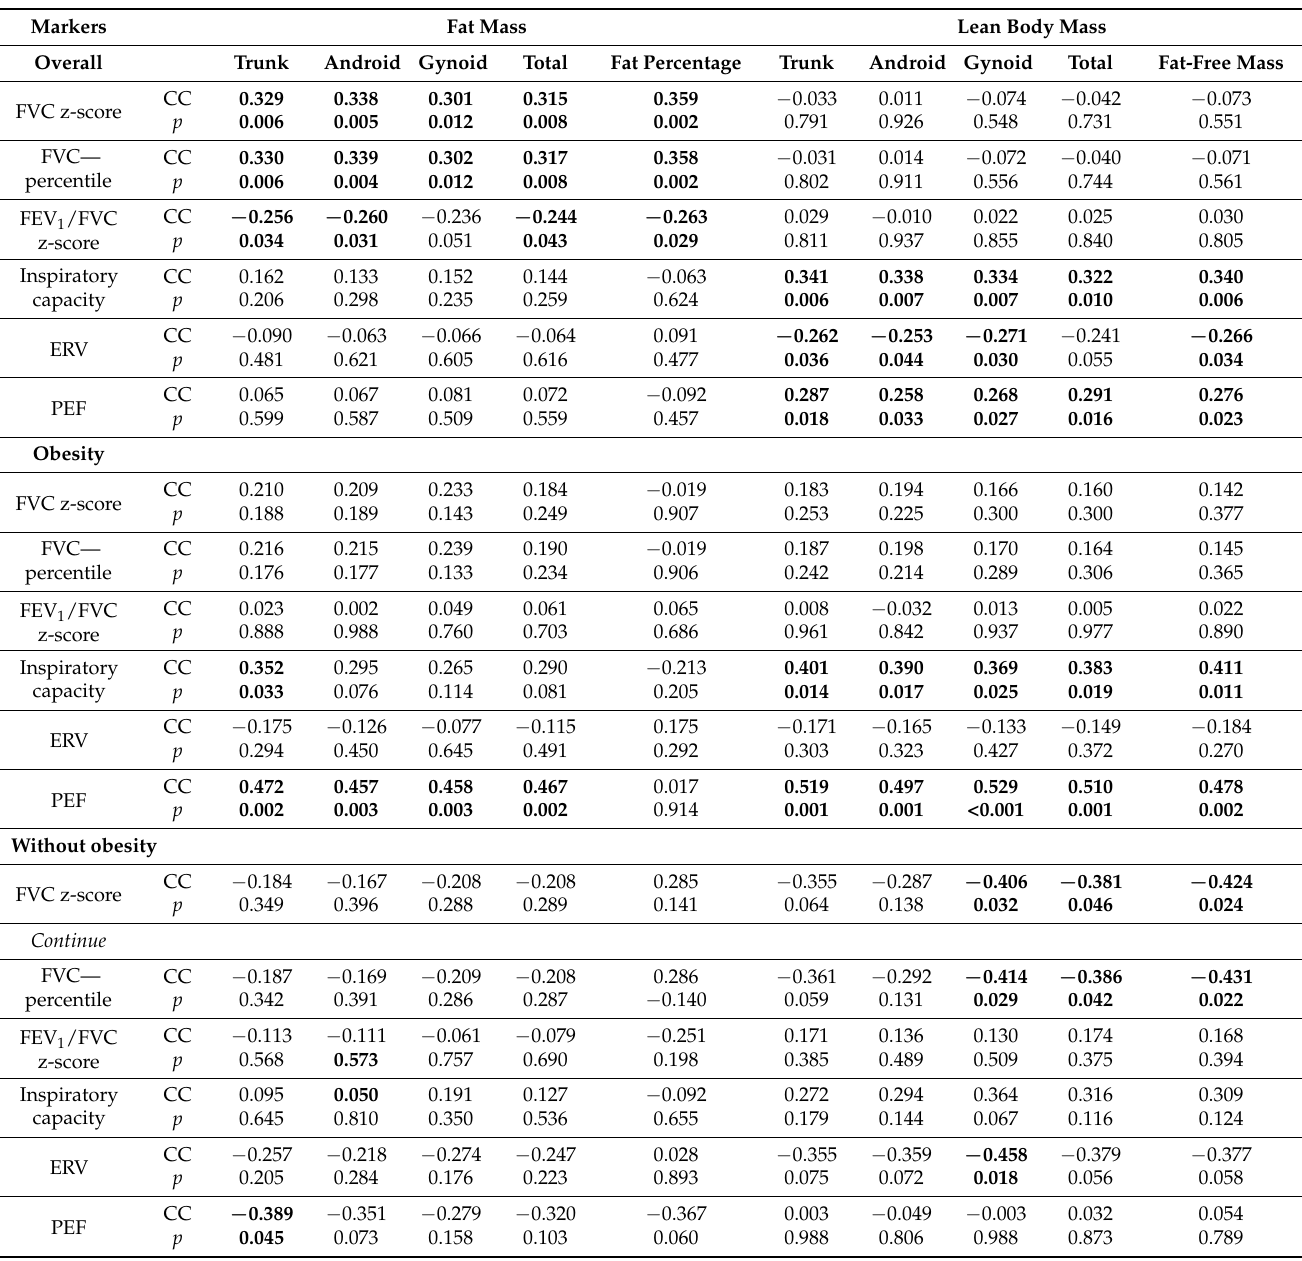
Table 4. Correlation between pulmonary function markers and body composition, respectively, evaluated by spirometry and dual-energy X-ray